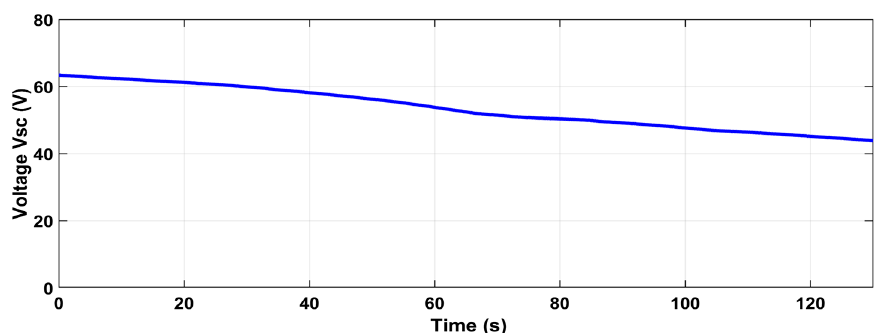
Figure 13. Battery voltage 𝒗 𝒃𝒂𝒕 .